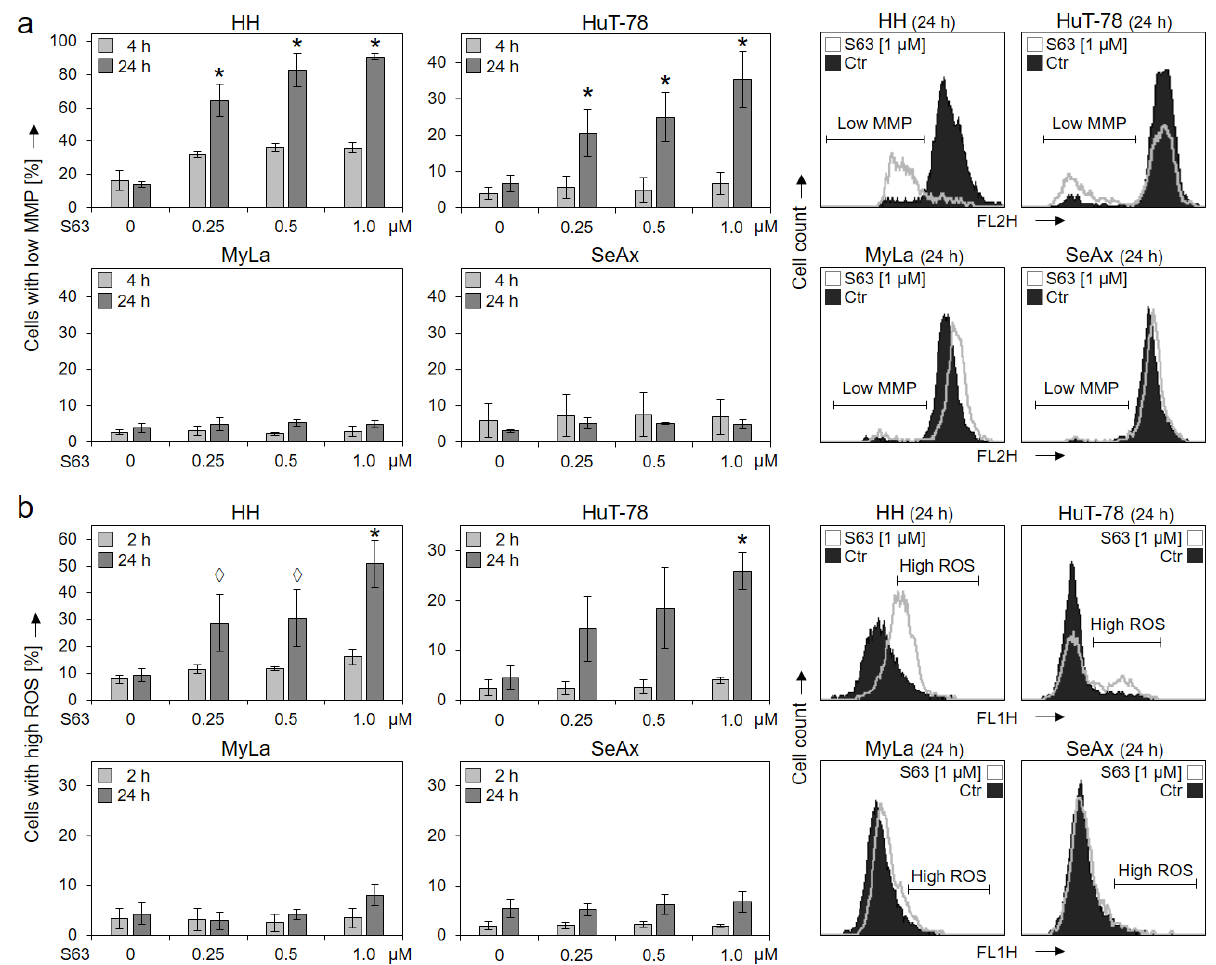
Figure 2. Loss of MMP and enhanced ROS levels in sensitive cells. Cell lines HH, HuT-78, MyLa and SeAx were treated with increasing concentrations of S63845 (0.25, 0.5, 1.0 µM). Changes of mitochondrial membrane potential (MMP, TMRM + staining) were determined at 4 h and at 24 h of treatment ( a ); levels of reactive oxygen species (ROS, H 2 DCF-DA staining) were determined at 2 h and at 24 h of treatment ( b ). Representative histograms (overlays of cells treated for 24 h with 1 µM S63845 vs. controls, Ctr) are given on the right side. Mean values of triplicates ± SD of representative experiments are shown here; three independent experiments were performed for 24 h, which had highly comparable results; two experiments were performed for 2 h/4 h (each one with triplicates). Statistical significance (24 h) was calculated from the mean values of independent experiments and is shown for treated cells vs. controls (*, p < 0.05). For some values, a statistical trend is also indicated ( , p < 0.1).